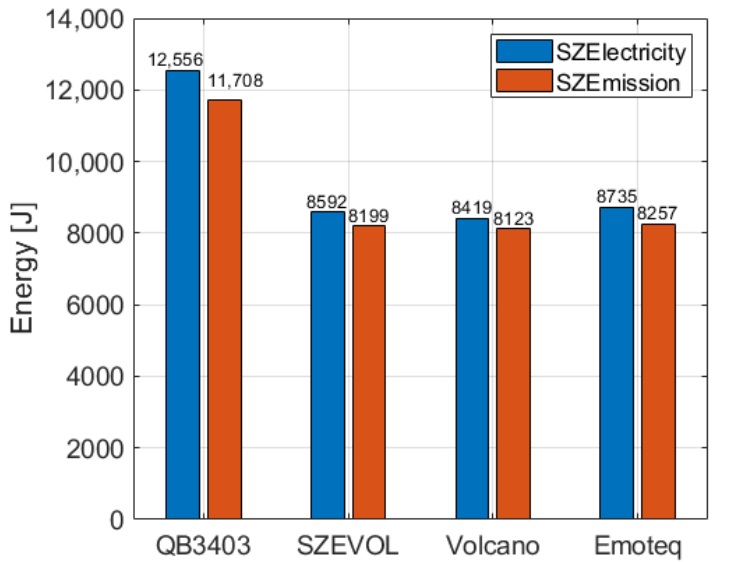
Figure 10. Consumed electric energy of the powertrains with the optimized torque reference acceleration until reaching 30 km/h.